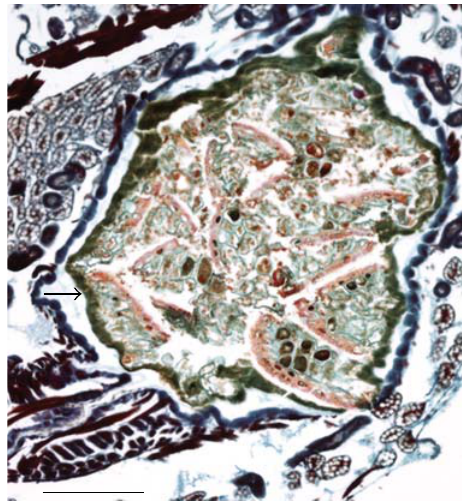
Figure 18: Fecal pellet surrounded by a sheath (arrow) formed from the peritrophic membrane in the bulbous rectum of a N. abietis larva. Scale bar = 0.2mm.